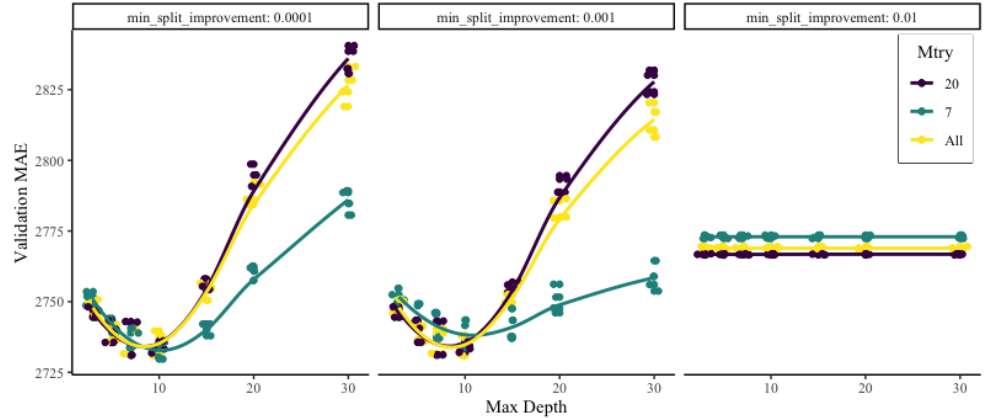
Figure 11. Visualization of the results from tuning random forests to predict severity on the PD data. MAE (as computed on the validation set) is shown on the y -axis as it varies according to the max depth of each tree in the forest. Each pane shows a different minimum split improvement value, with the different colors representing different values of the mtry tuning